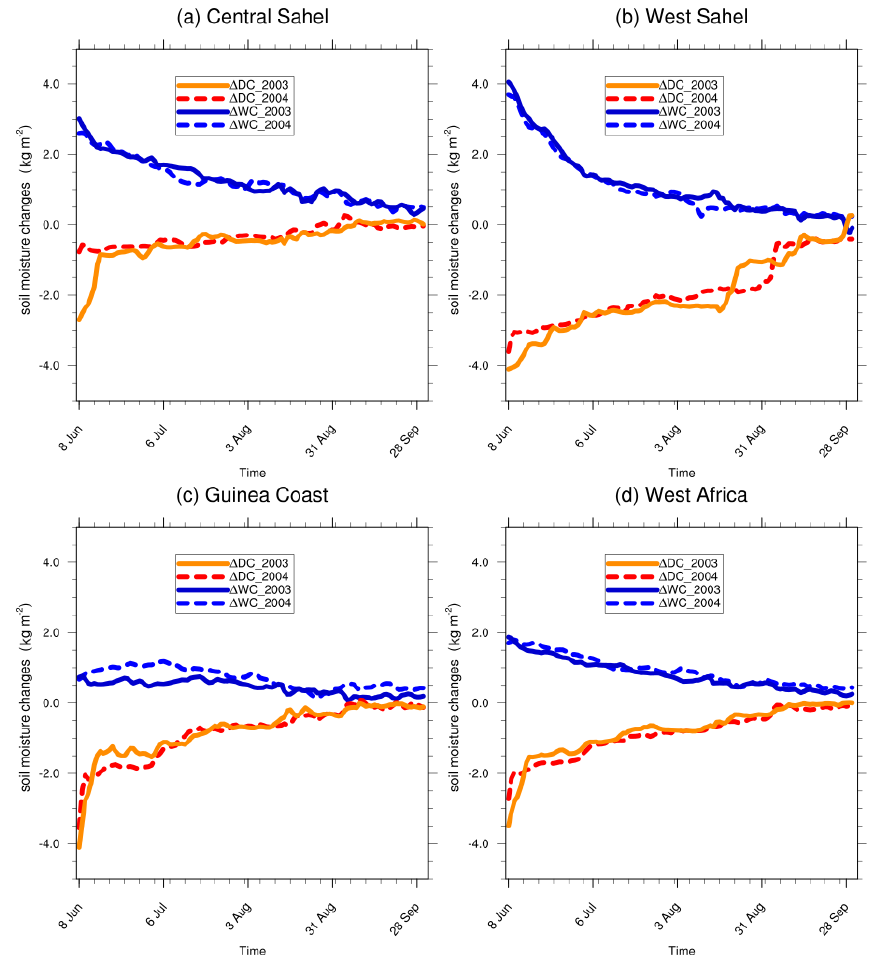
Figure 6. Daily domain-averaged soil moisture changes for JJAS 2003 and JJAS 2004 from dry ( (cid:49) DC) and wet ( (cid:49) WC) experiments with respect to the control